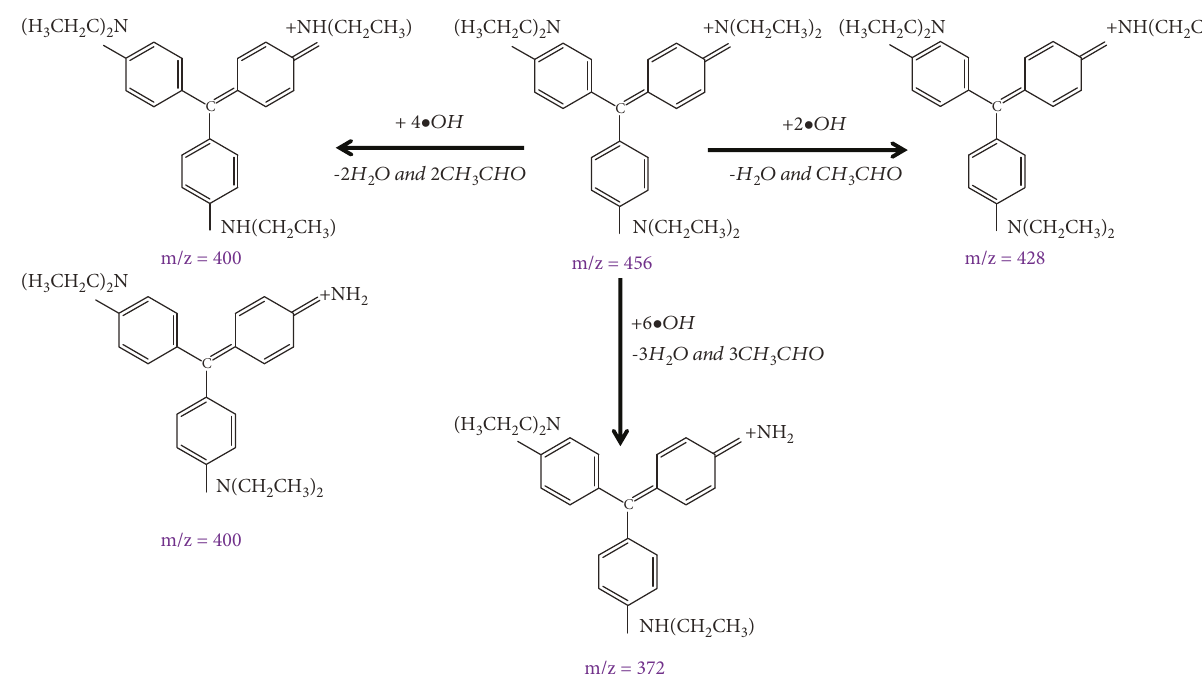
Scheme 1: The primary degraded products of EV